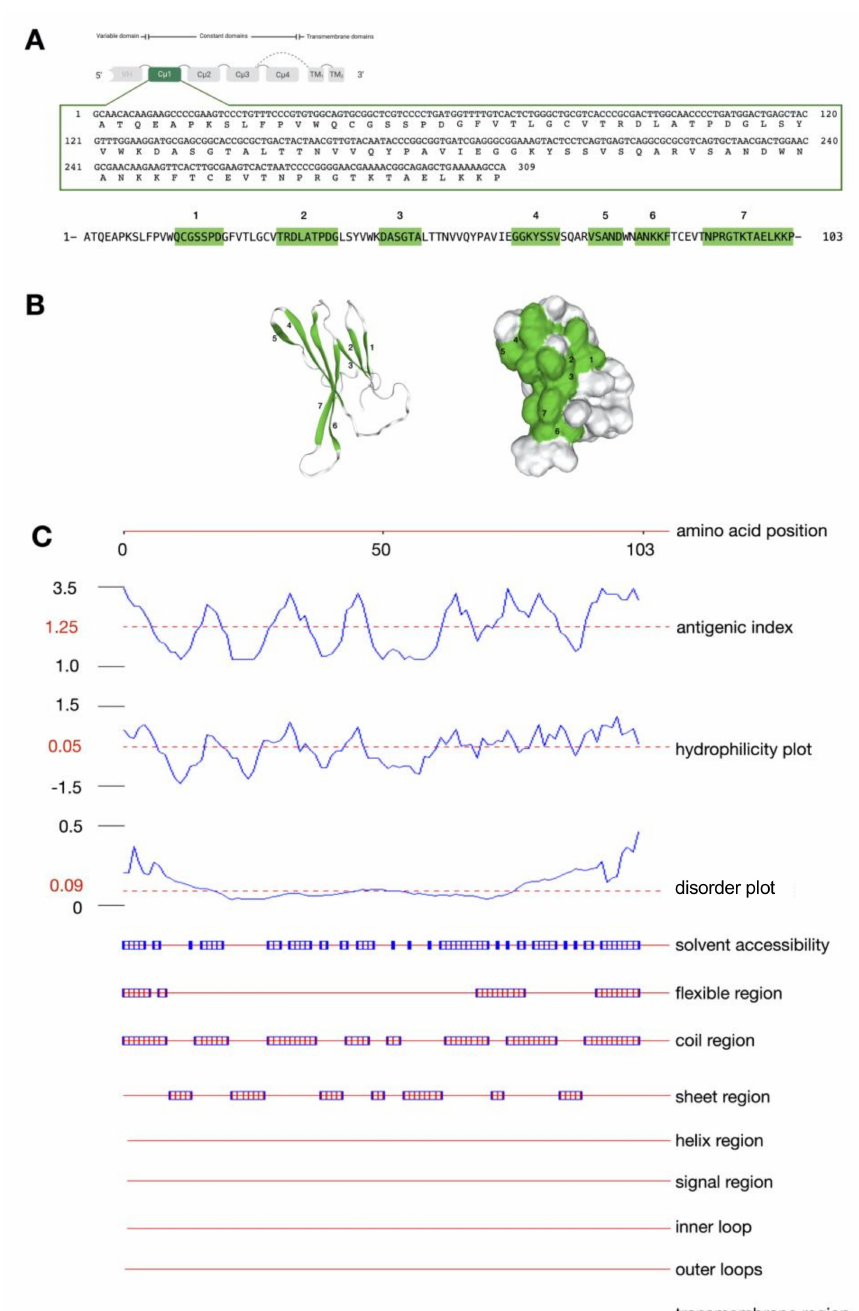
Figure 2. Nucleotide and amino acid sequences for the C µ 1 protein of the IgM heavy chain of bighead catfish ( A ), amino acid sequence and schematic structures indicate the antigenic determinant regions located in the C µ 1 protein (highlighted in green) ( B ), and in silico analysis of the immunogenetic determinant property of the C µ 1 protein of the IgM heavy chain of bighead catfish ( C